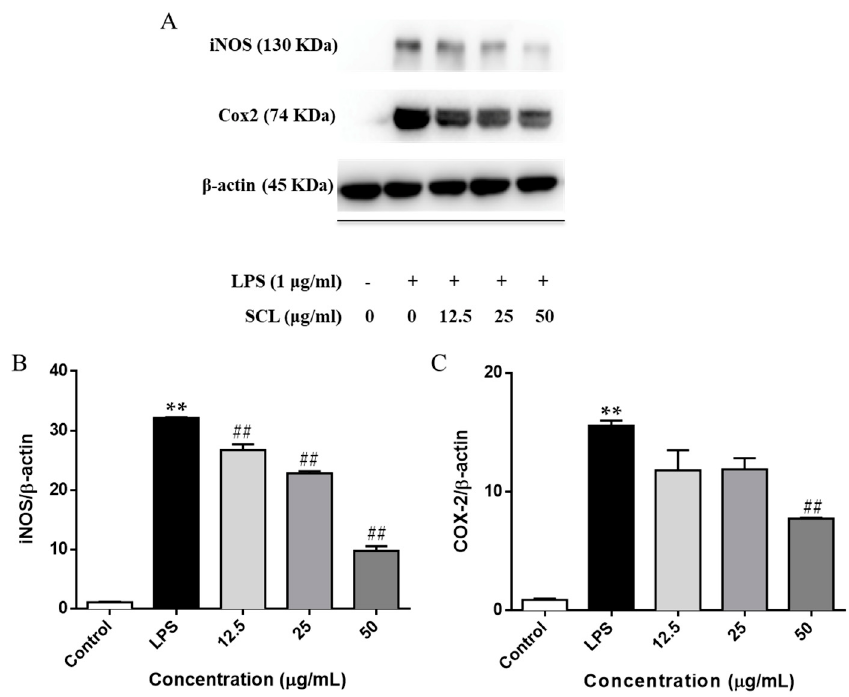
Figure 3. Effect of SCL on iNOS and COX-2 expression in LPS-stimulated RAW264.7 cells. Cells were treated with SCL at various concentrations (12.5, 25 and 50 μ g/mL) for 1 h, and then stimulated with or without LPS for 24 h, the expression of iNOS and COX-2 were investigated by Western blotting. ( A ). The data presented in bar charts indicates the relative levels of iNOS and COX-2 ( B and C ). Values given are the mean ± SEM of 3 independent experiments; ** p < 0.01 vs. unstimulated cells. ## p < 0.01 vs. LPS-stimulated cells.